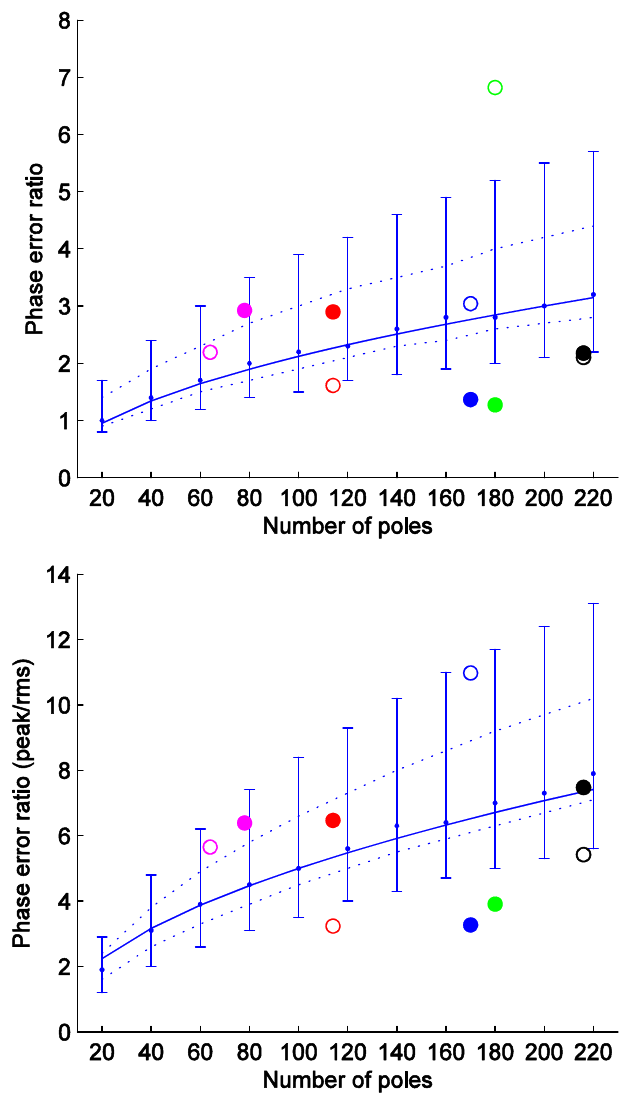
FIG. 9. Ratio between (cid:1) and (cid:1) c (upper) and between ’ max ’; eff and (cid:1) c (lower) as a function of the number of poles in an undulator for random sets of local phase errors ( c ). Blue data i points show the most probable values, error bars contain 90% of the population, and dotted lines 50% of the population. Data points correspond to the devices listed in Table I, with the corresponding